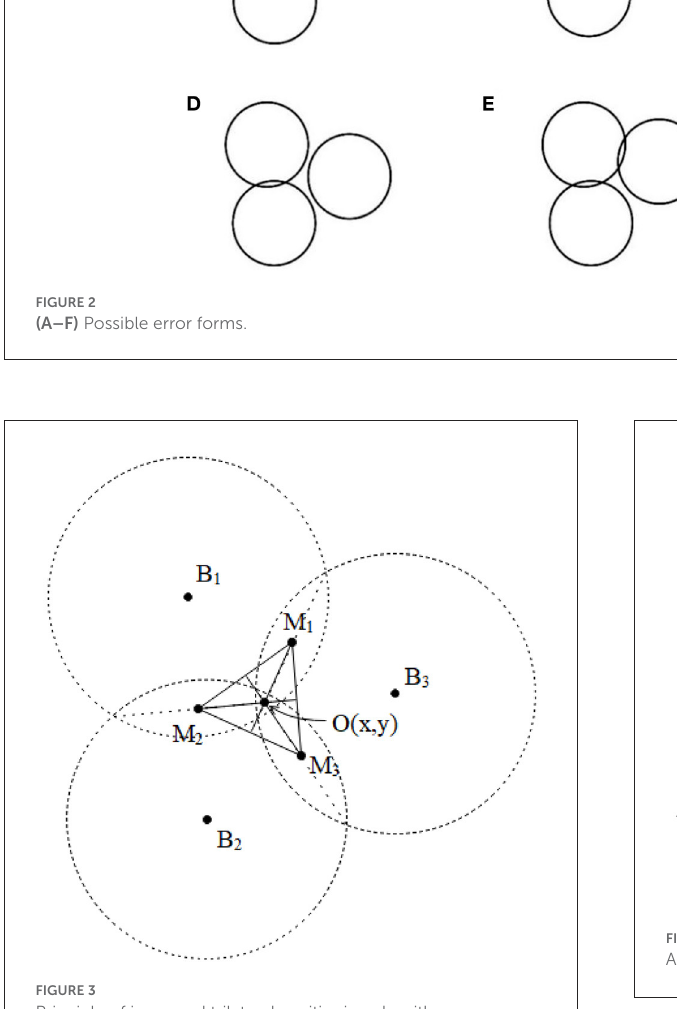
Deviations were observed for the distance measurement between nodes during actual measurement, due to the NLOS error in the indoor positioning environment and the effect of the hardware. Therefore, the circle obtained by trilateral positioning algorithm did not exactly correspond to the representation shown in Figure 1, but had multiple error forms as shown in Figure 2. Analysis indicated that the errors in trilateral positioning algorithm can be attributed to five factors as shown in Figure 2. In the first case, the circles were separated implying that the measured distance was less than the true distance;